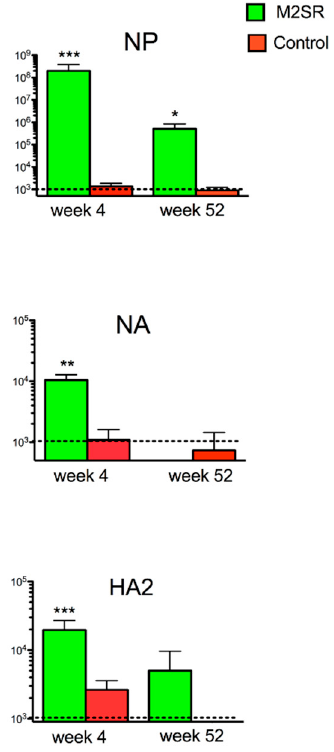
Figure 7. Durations of antibody responses to heterosubtypic influenza proteins (ELISA) after vaccination with M2SR. Groups of 6 mice were vaccinated with H1N1 M2SR-PR8 or mock-infected with PBS and serum antibody titers to influenza A/H3N2 proteins were determined using an ELISA 4 or 52 weeks later, as described in the Materials and Methods. Note: NP—nucleoprotein; NA—neuraminidase protein; HA2—HA2 region of the hemagglutinin molecule. Significantly different from mock infected control: * p < 0.05, ** p < 0.01, *** p < 0.001 (Mann–Whitney test).